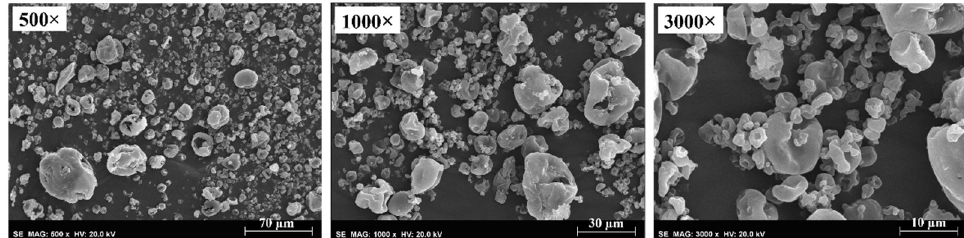
Figure 1. SEM images of HPC microparticles with 7.5 % w / v of HPC at 500×, 1000× and 3000× magnifications.